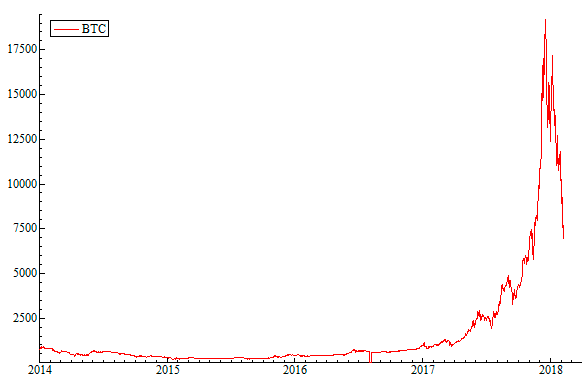
( A ) Time series plots of Bitcoin